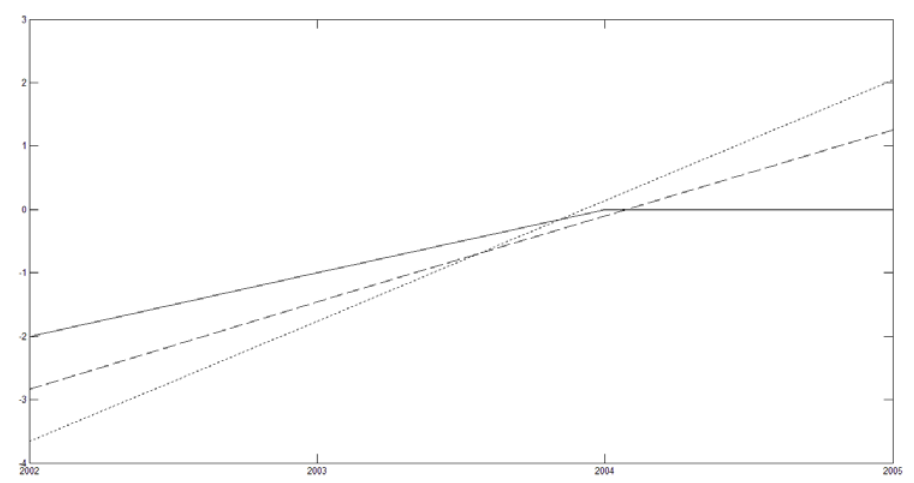
Figure 4. Constant slope